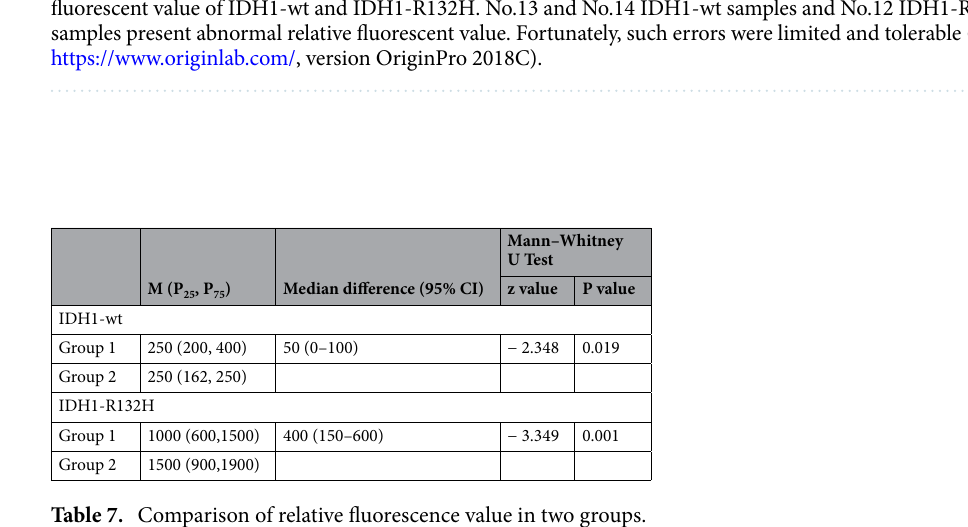
Table 7. Comparison of relative fluorescence value in two